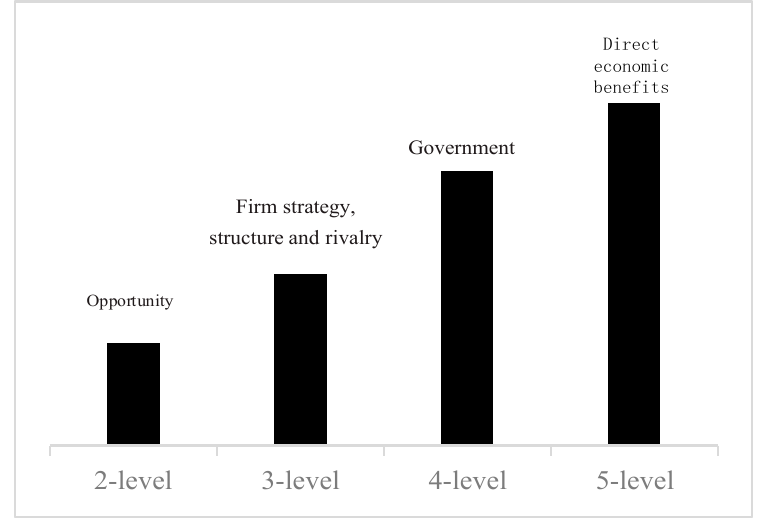
Figure 4. Key factors that play leading roles at different driving strengths.